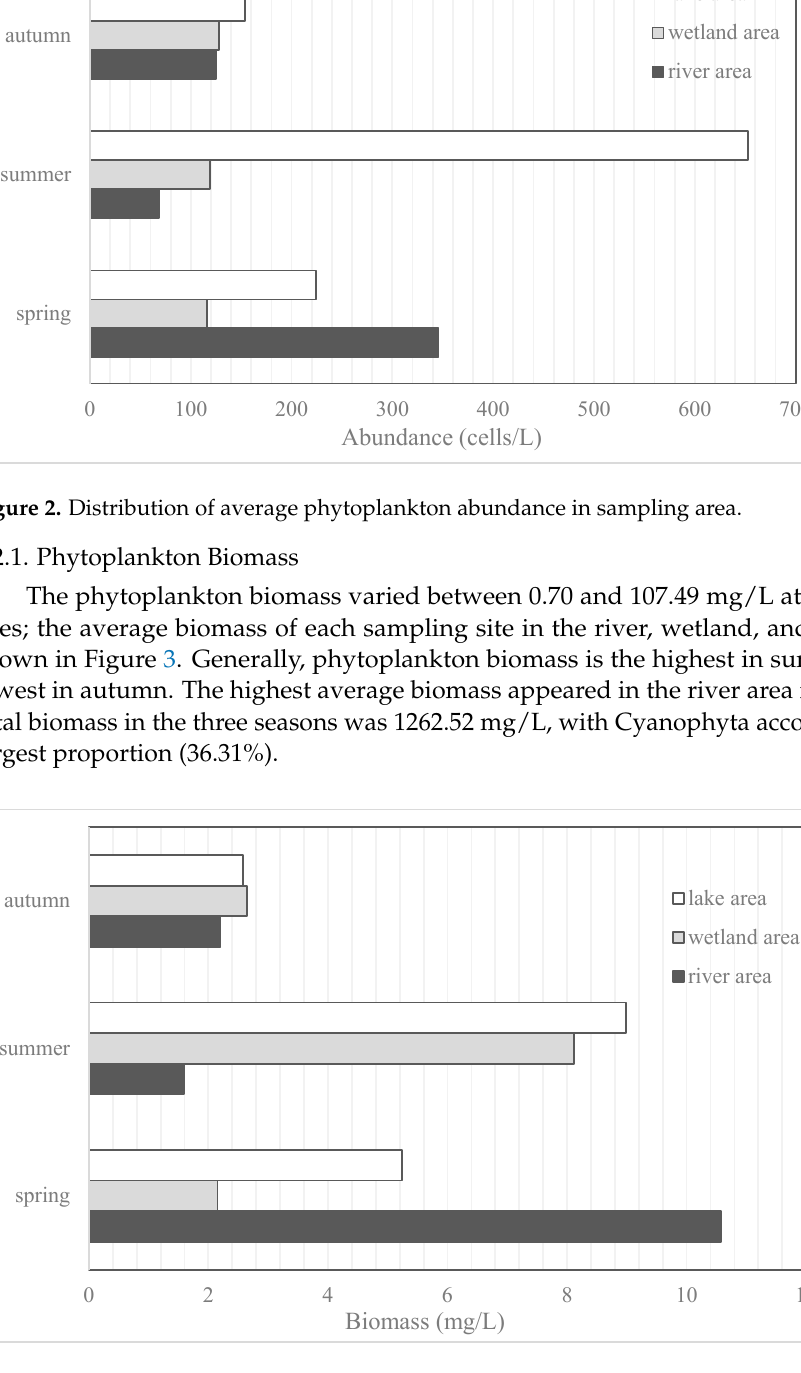
Table 1. Distribution of dominant phytoplankton species within Zhalong National Nature Reserve. Dominant Index Species Spring Summer Autumn Lake Area River Area Wetland Area Bacillariophyta